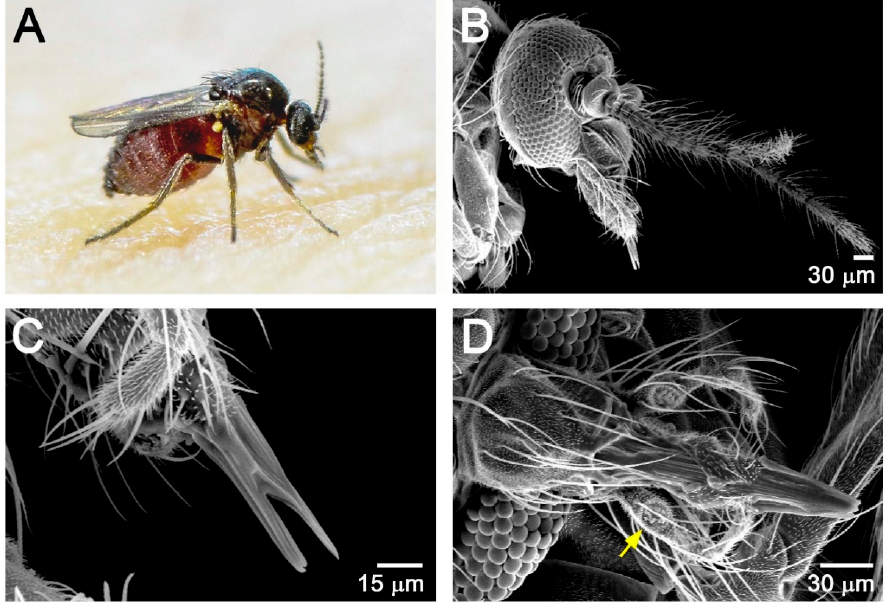
Figure 1. Morphology of female F. taiwana. ( A ) A blood-feeding female. ( B , C ) Scanning electron microscopy examination of head ( B ) and the short rasping-sucking mouthpart ( C ). ( D ) Dorsal view of the sucking-rasping mouthpart. Sensilla chaetica are located at a swollen pit (yellow arrow) of the third segment of maxillary